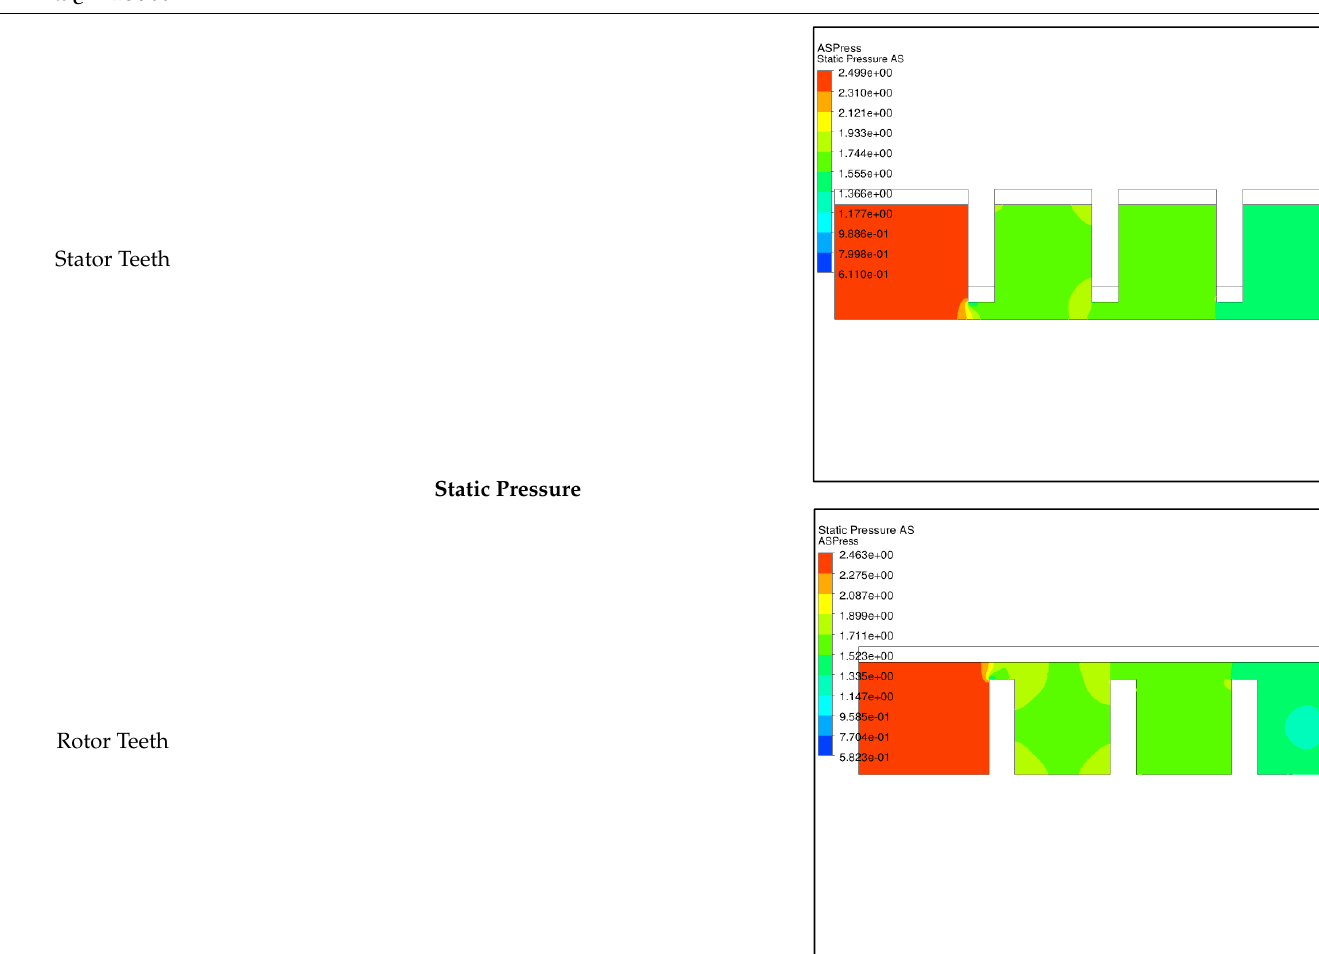
Table A2. Static pressure fields.